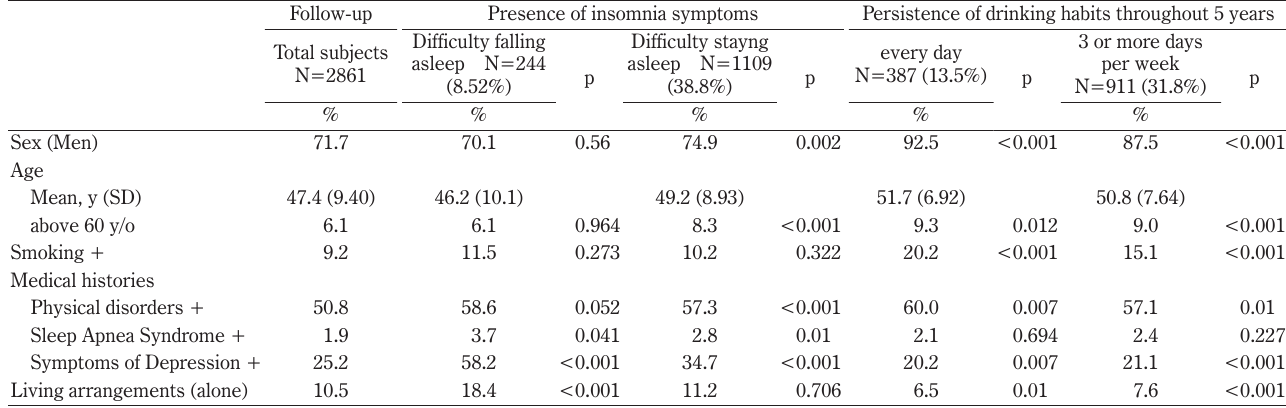
Drinking frequencies Every day + 3 or more days/week + Every day – 3 or more days/week – OR (95% CI) OR (95%